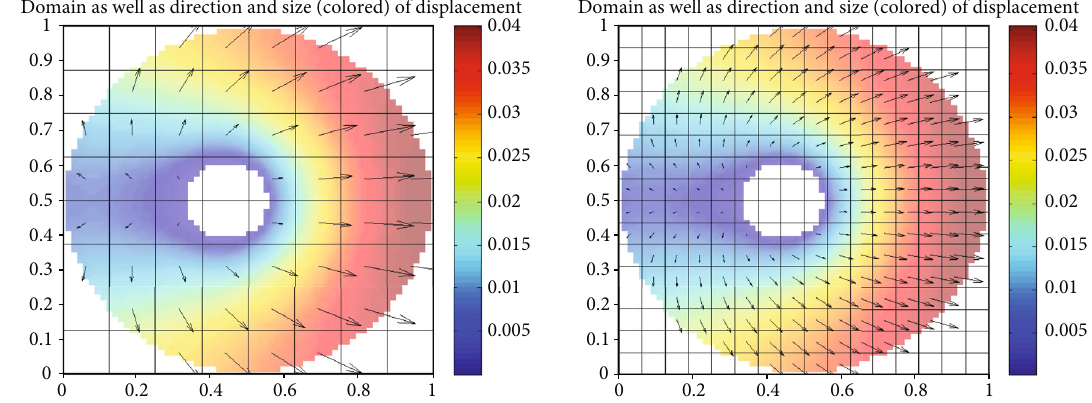
Figure 5: Numerical solution for H = 8, 16 .